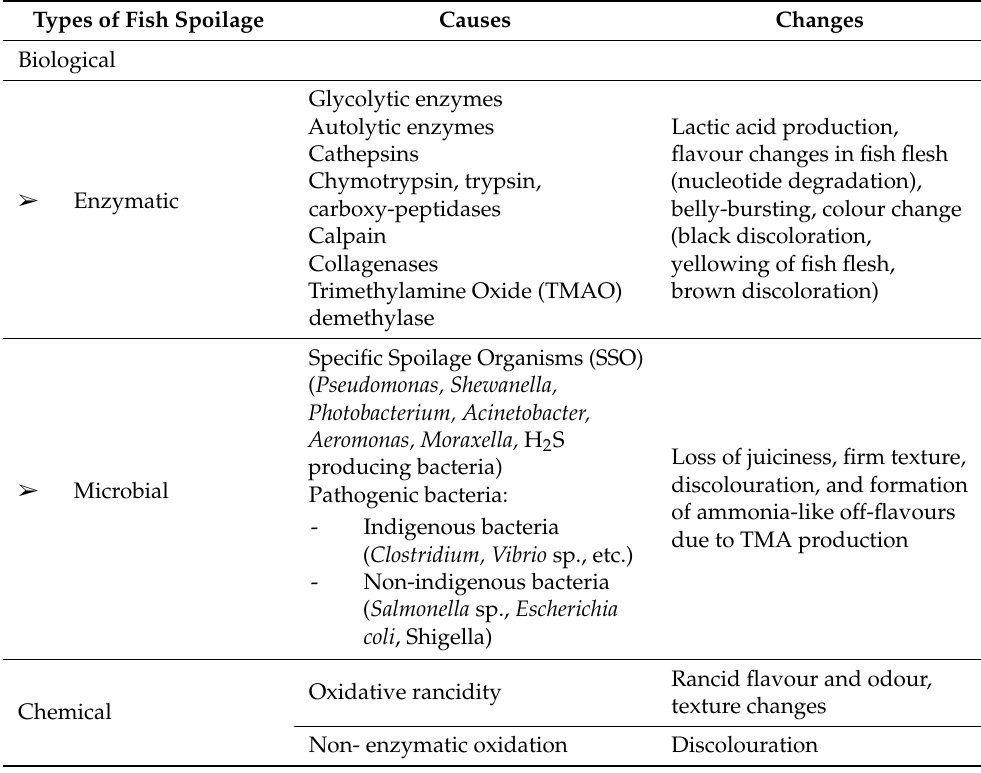
Table 1. Types of spoilage, causes and main changes observed in spoiled